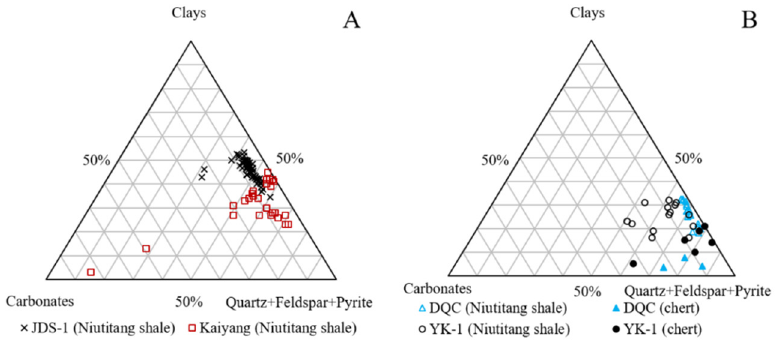
Figure 4. Ternary diagram of the mineralogical compositions of the Niutitang shale and chert from ( A ) Kaiyang well [31] and Jindingshan-1 (JDS-1) well deposited on the carbonate platform; ( B ) Yuke-1 (YK-1) well [32] and the Danquancun (DQC) section deposited on the carbonate platform marginal zone. The minerals of Kaiyang and JDS-1 wells are similar, and the minerals of the DQC section and YK-1 well are similar.